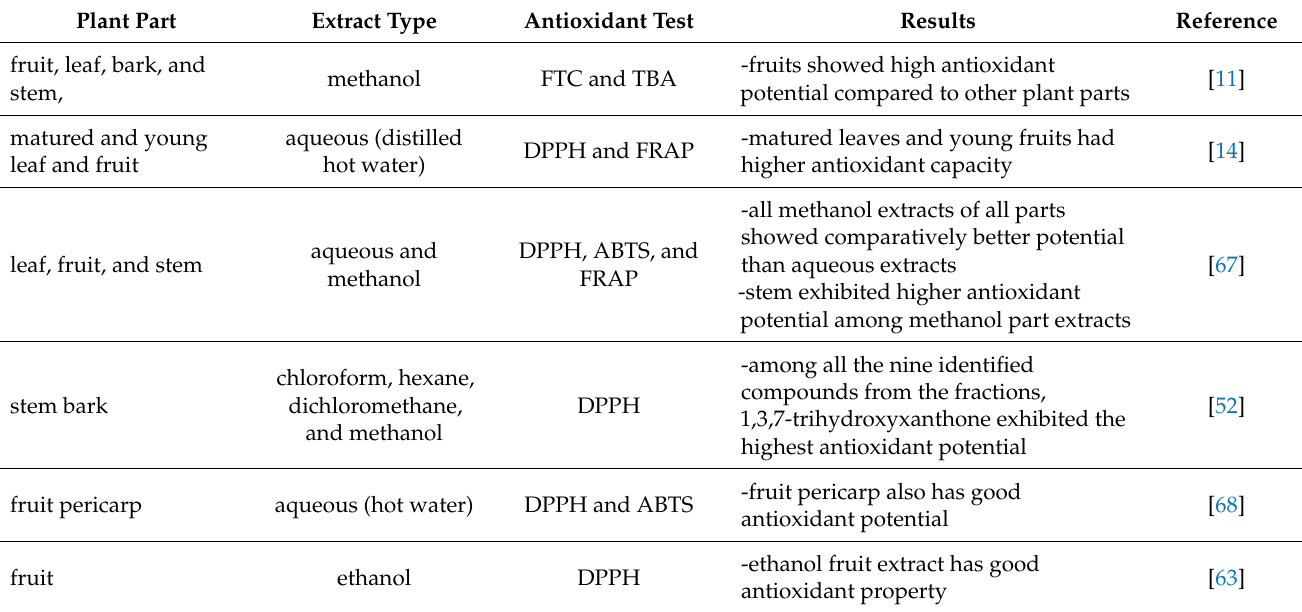
Table 3. Antioxidant activities of various extracts of G. atroviridis